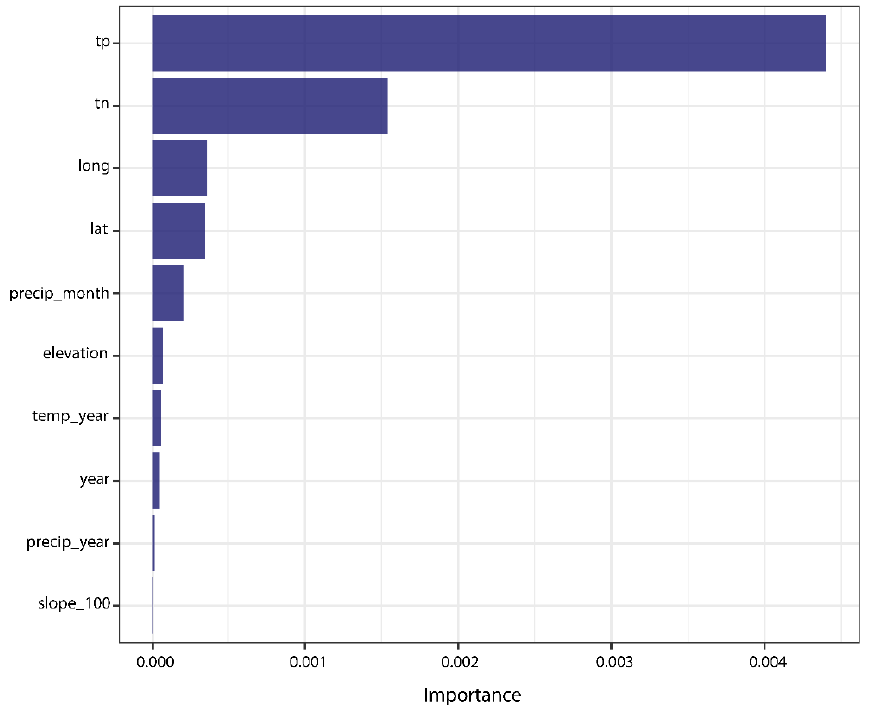
Figure 4. Order of importance of the random forest model variables.